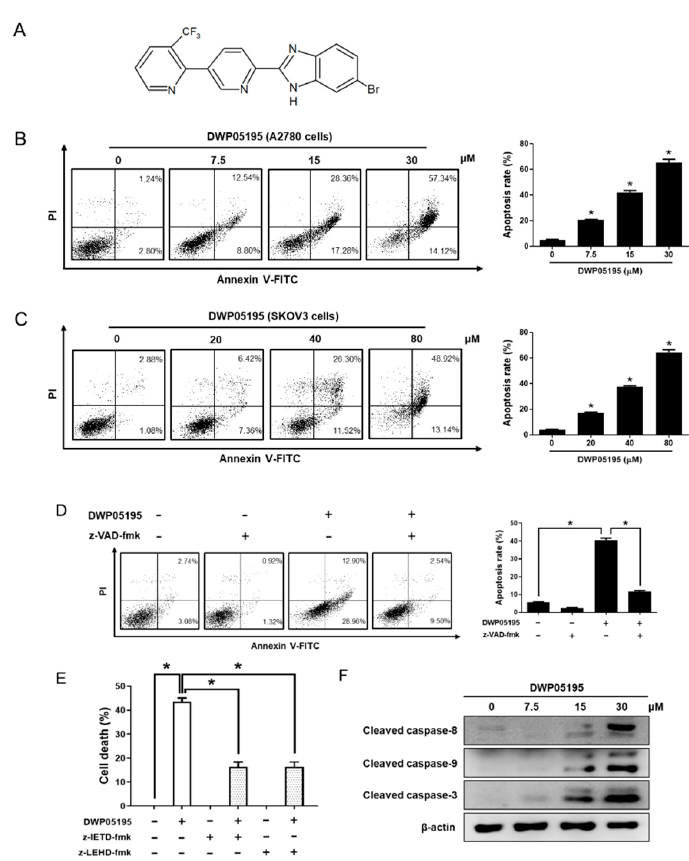
Figure 1. E ff ect of DWP05195 on apoptosis in A2780 and SKOV3 cells. ( A ) Chemical structure